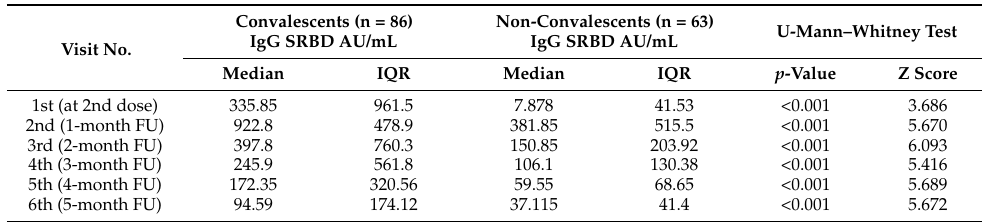
Table 3. The serum levels of SRBD IgG antibodies in COVID-19 convalescents and non-convalescents at baseline and follow-up